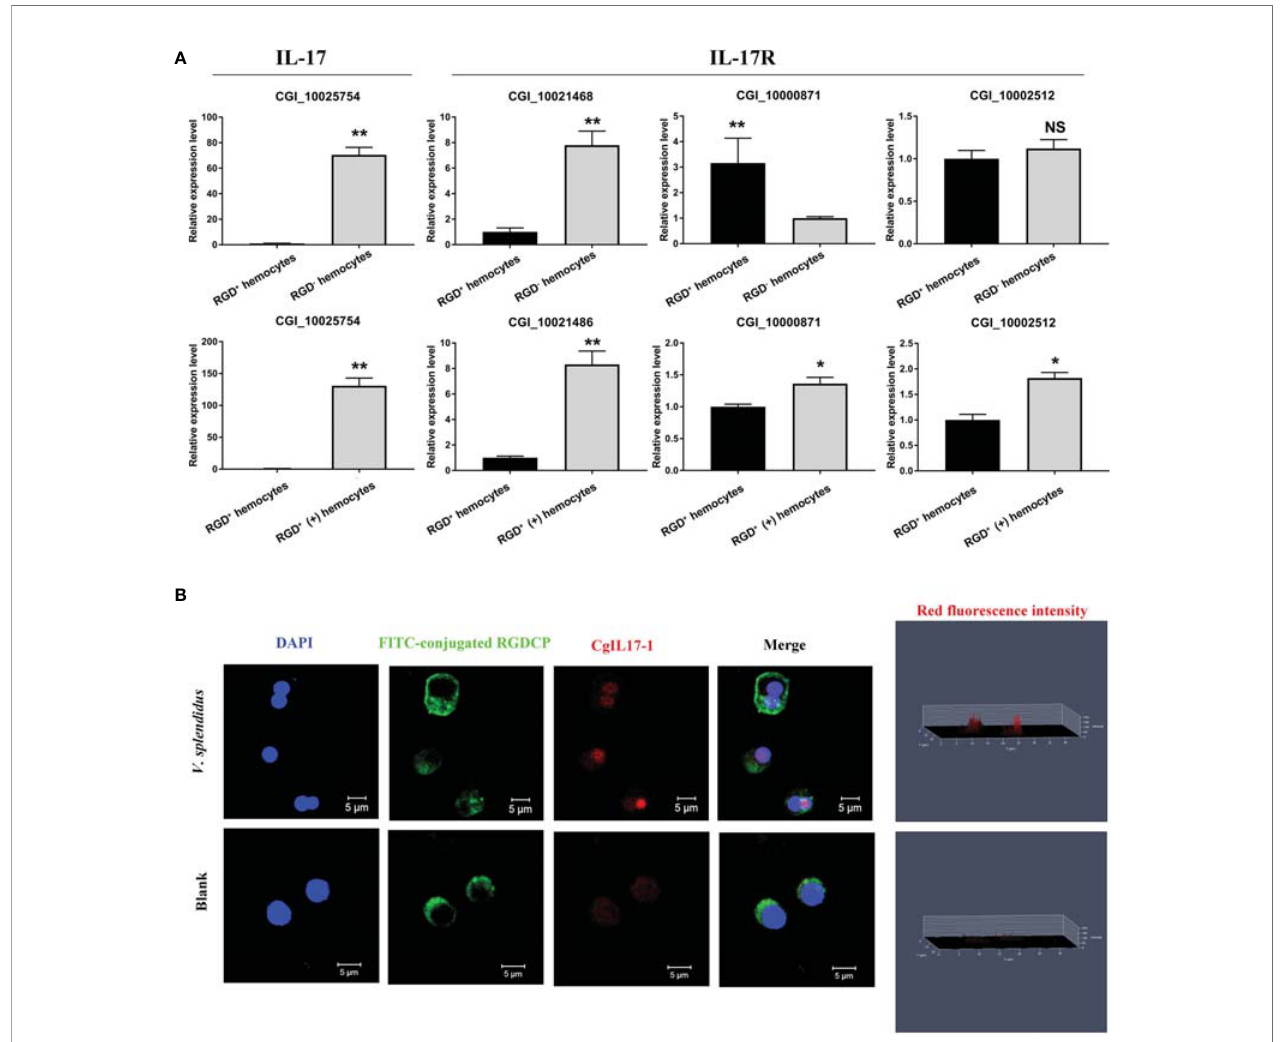
FIGURE 8 | The expression pro fi les of IL-17s and their receptor genes. (A) qPCR validation of differentially expressed IL-17s and their receptor genes in resting RGD + hemocytes compared to resting RGD - hemocytes and in activated RGD + hemocytes compared to resting RGD + hemocytes. (B) Immuno fl uorescence validation of Cg IL17-1 (CGI_10025754) in activated RGD + hemocytes compared to resting RGD + hemocytes. FITC-conjugated RGDCP-labeled oyster integrins on cell membranes are indicated in green, the cell nucleus stained by DAPI is indicated in blue, and the Cg IL17-1 antibody conjugated with Alexa Fluor 594 is indicated in red. Bar = 5 m m. The asterisk (*) and the double asterisk (**) stand for statistical signi fi cance at p < 0.05 and p < 0.01 respectively and “ NS ” represents no statistical signi fi